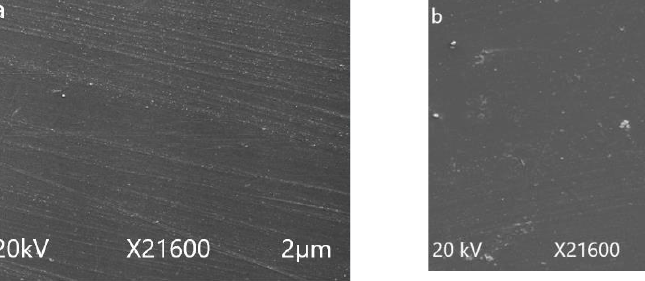
Figure 9. Scanning electron microscopy images of unaged samples. ( a ) neat epoxy, ( b ) EMC, ( c ) ENC.